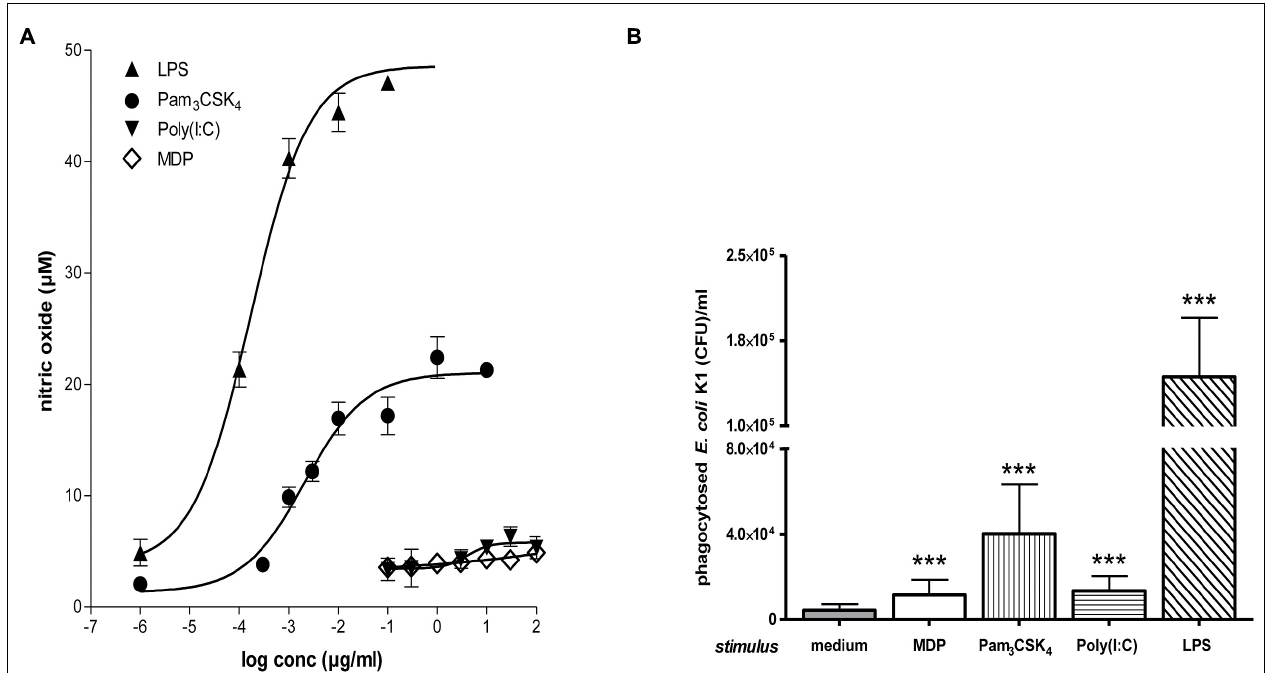
concentration inducing maximum NO release: 0.1 μ g/ml Pam 3 CSK 4 , 10 μ g/ml poly(I:C), 0.01 μ g/ml LPS, and 10 μ g/ml MDP (means ± SD, ∗∗∗ p < 0.001 vs. medium-treated cells); Student’s t test and correction for repeated testing by the Bonferroni–Holm method. Please note that although stimulation with poly(I:C) and MDP released low amounts of NO, both compounds led to a substantial increase of bacterial phagocytosis (Figure reproduced from Ribes etal., 2012, with permission of the